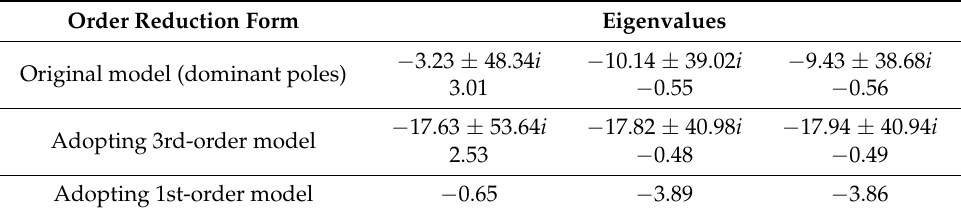
Table 8. Dominant eigenvalues of test system 2 order reduction at unstable